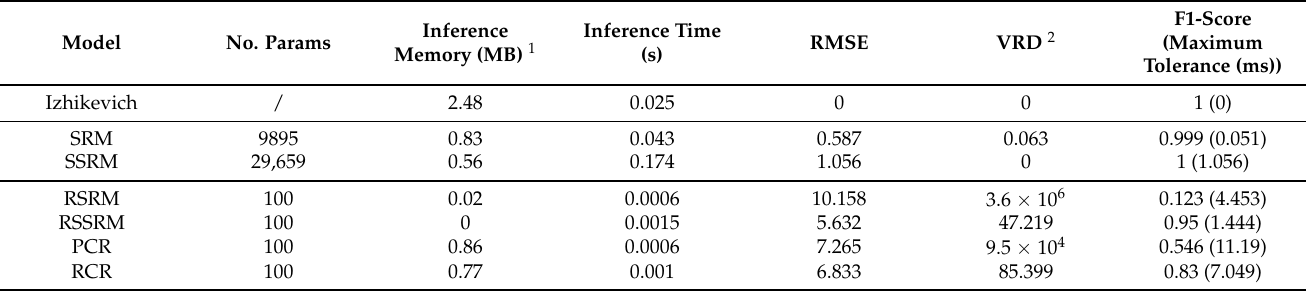
Table 3. Average performance on twenty firing behaviors.